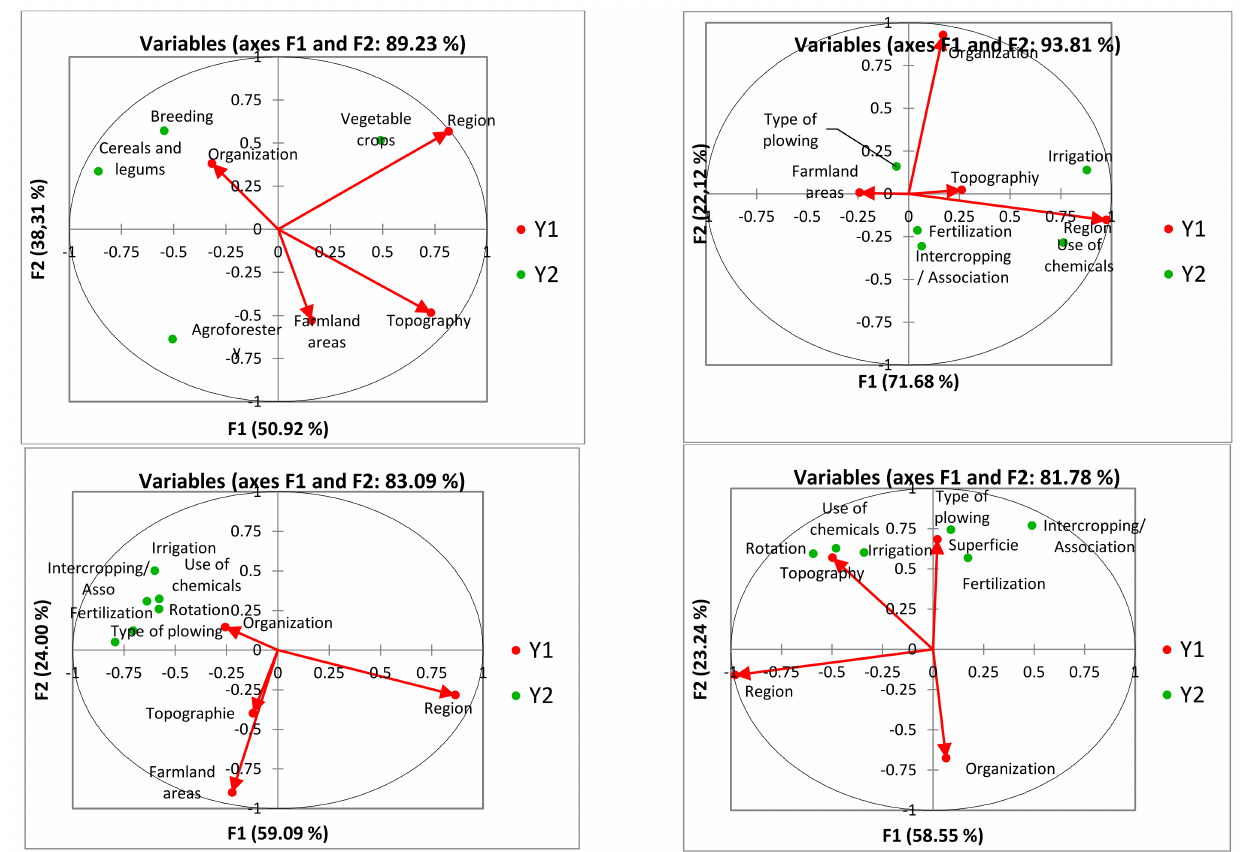
Figure 2. Characteristics of farms, crop types and agricultural practices of interviewees under CCA constructed according to data collected. Full questions are presented in Tables 1 and